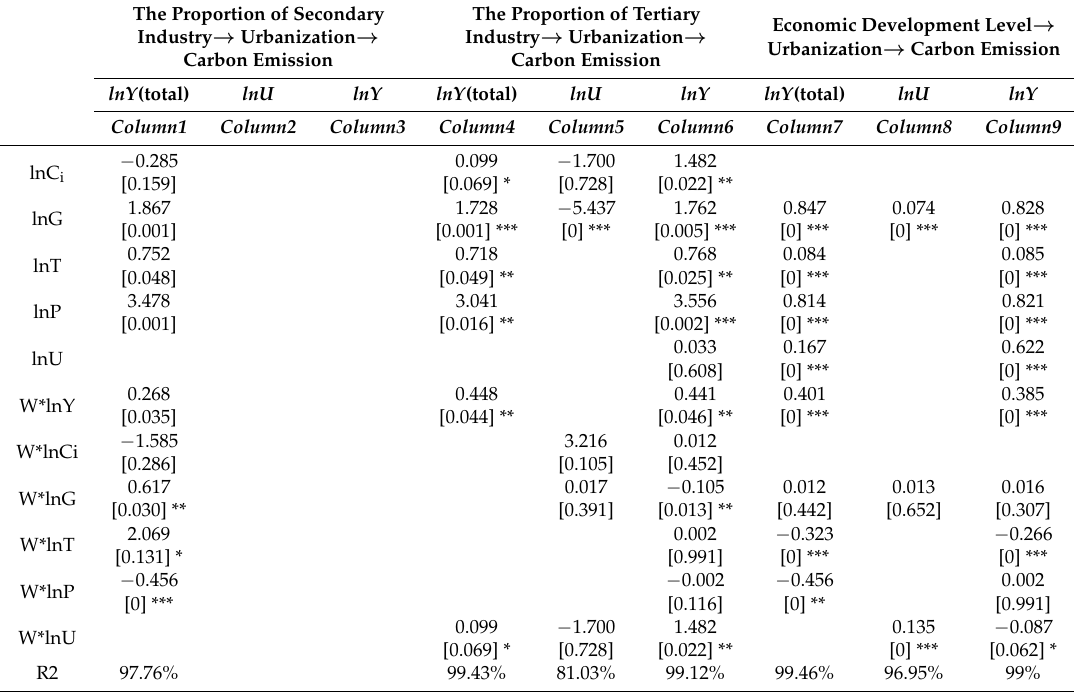
Table 7. The impact path test result of related variables → urbanization → carbon